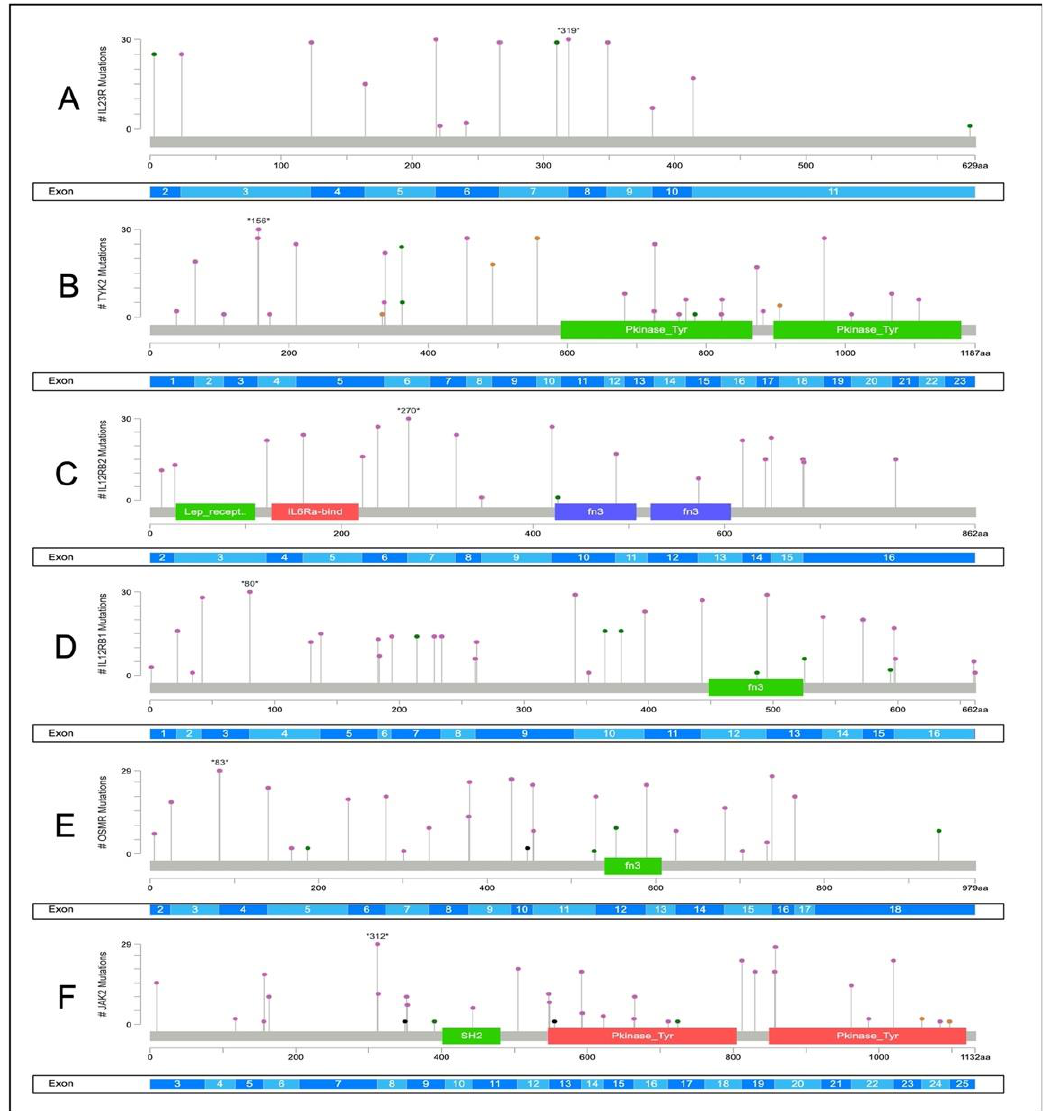
Figure 3. Distribution of somatic mutations within the functional domain of each gene. Circle and the hues green (missense), black (truncating mutation), and purple symbolize the mutations of other genes. The number with asterisk displays the location of protein change. The number of mutations identified in the coding area is shown by the length of the line. ( A ) IL23R , ( B ) TYK2 , ( C ) IL12Rß2, ( D ) IL12Rß1 , ( E ) OSMR , and ( F ) JAK2 changes were identified.